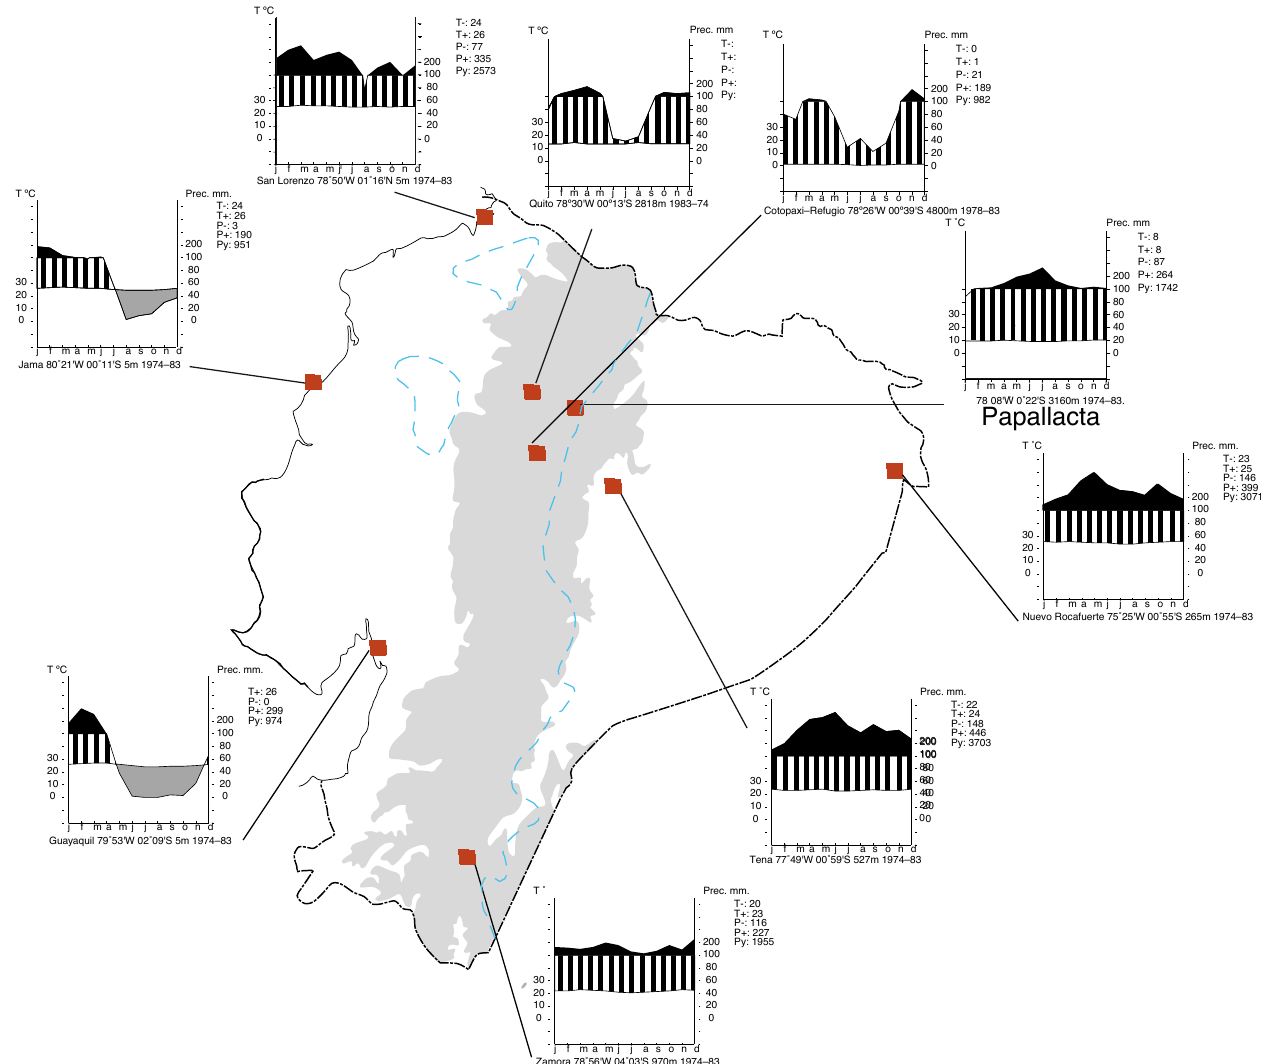
Fig. 2. Map of Ecuador with the 2500m altitudinal limit (blue line) and climate diagrams drawn for the different regions (from Jorgensen and Ulloa Ulloa,